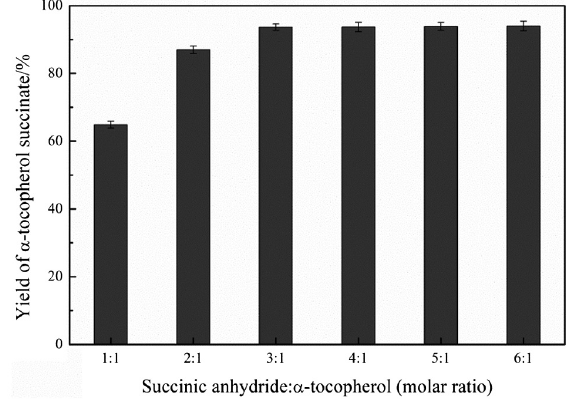
Figure 8: Effect of molar ratio of substrates. Conditions of reaction: 0.15 mmol α-tocopherol, 0.15 to 0.75 mmol succinic anhydride, 0.10 mmol NS-DMAP, hexane/acetone(4 mL/1 mL), 55°C, nitrogen, 16 h.